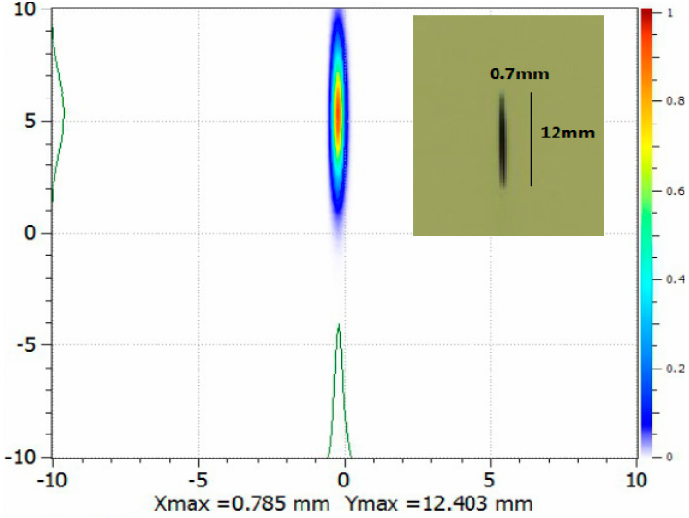
Figure 4. Comparison between the simulation results and the experimental measurements (inset) for the 10 MeV proton beam spot along the PMQs